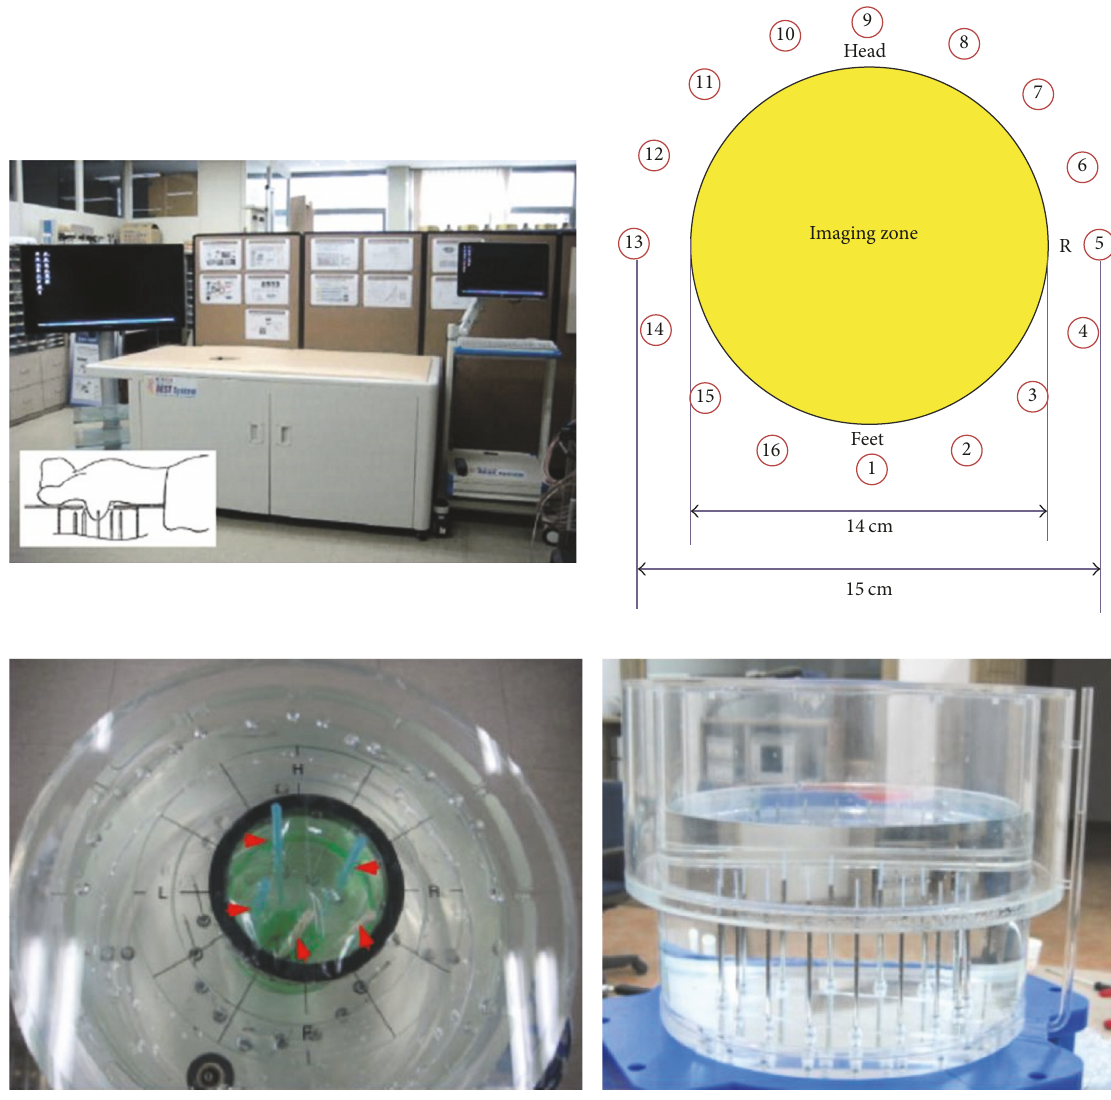
Figure 13: ETRI microwave tomography system [21]. Image copyright ETRI, used with